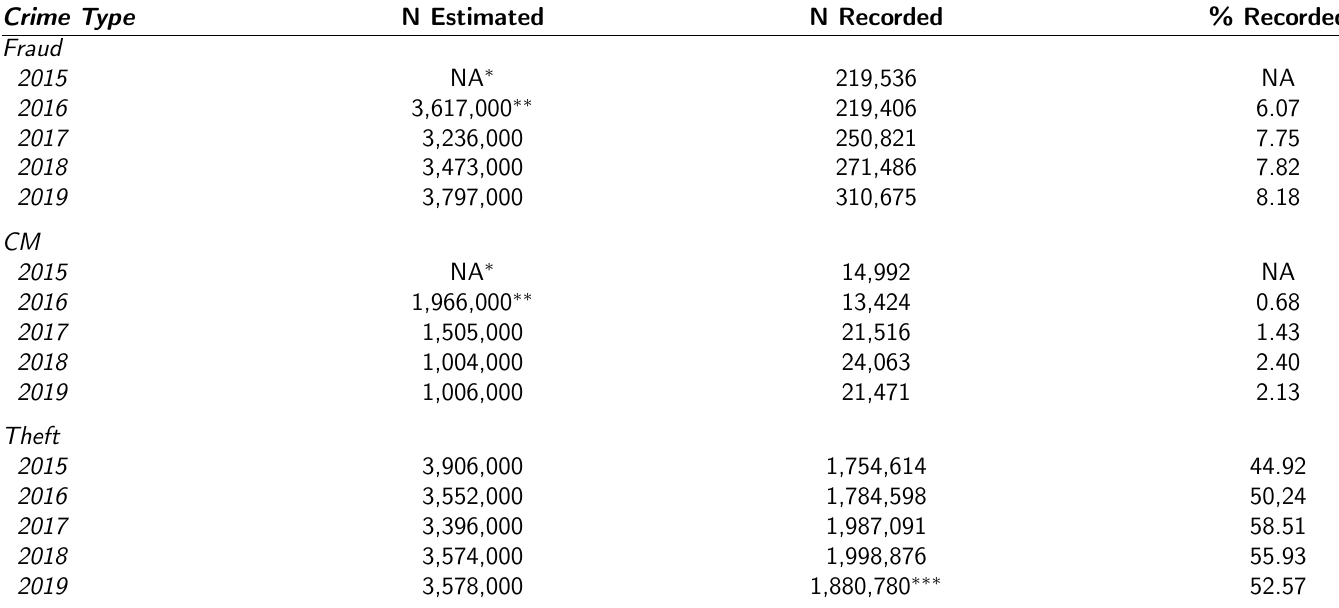
Table 2: Number of ONS estimated crimes, AF recorded crimes and % of recorded crimes for years ending September [21, 24–27] Crime Type N Estimated N Recorded %